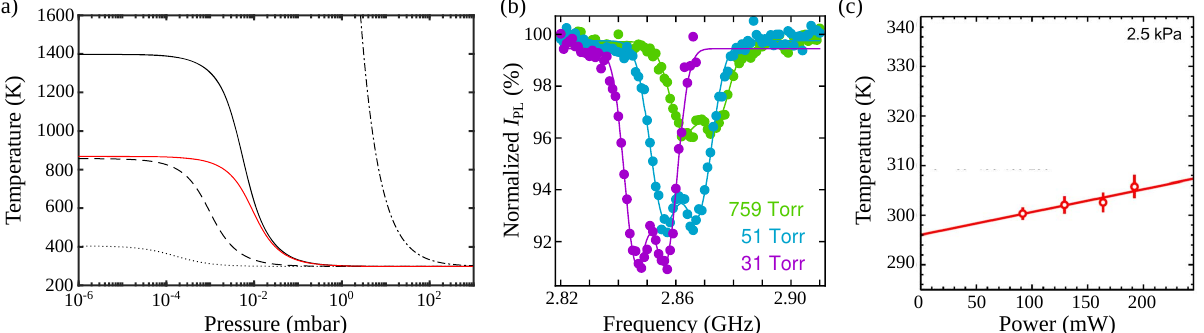
Figure 9. Internal heating of levitated diamonds. ( a ) Expected internal temperature of optically levitated nano-diamonds of different purity as a function of background gas pressure. The temperature dependence is shown for standard commercial diamond (– · –) up to the best expected grade (dotted line). The red-line corresponds to silica. Adapted from [98]. ( b ) Electron spin resonance from optically levitated nano-diamonds at different pressures. A clear shift of the central ESR frequency demonstrates diamond heating. Adapted from [55]. ( c ) Internal temperature of an optically levitated nano-diamond hosting a single NV − center as a function of trapping laser power. Adapted with permission from [53]. © The Optical